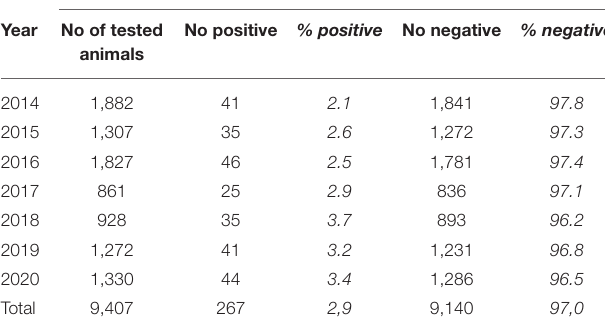
TABLE 2 | Results of tested herds by ELISA for the detection of antibodies within voluntary BVDV control programme in Slovenia (2014–2020). Tested herds - detection of BVDV antibodies (ELISA) Year No of tested herds